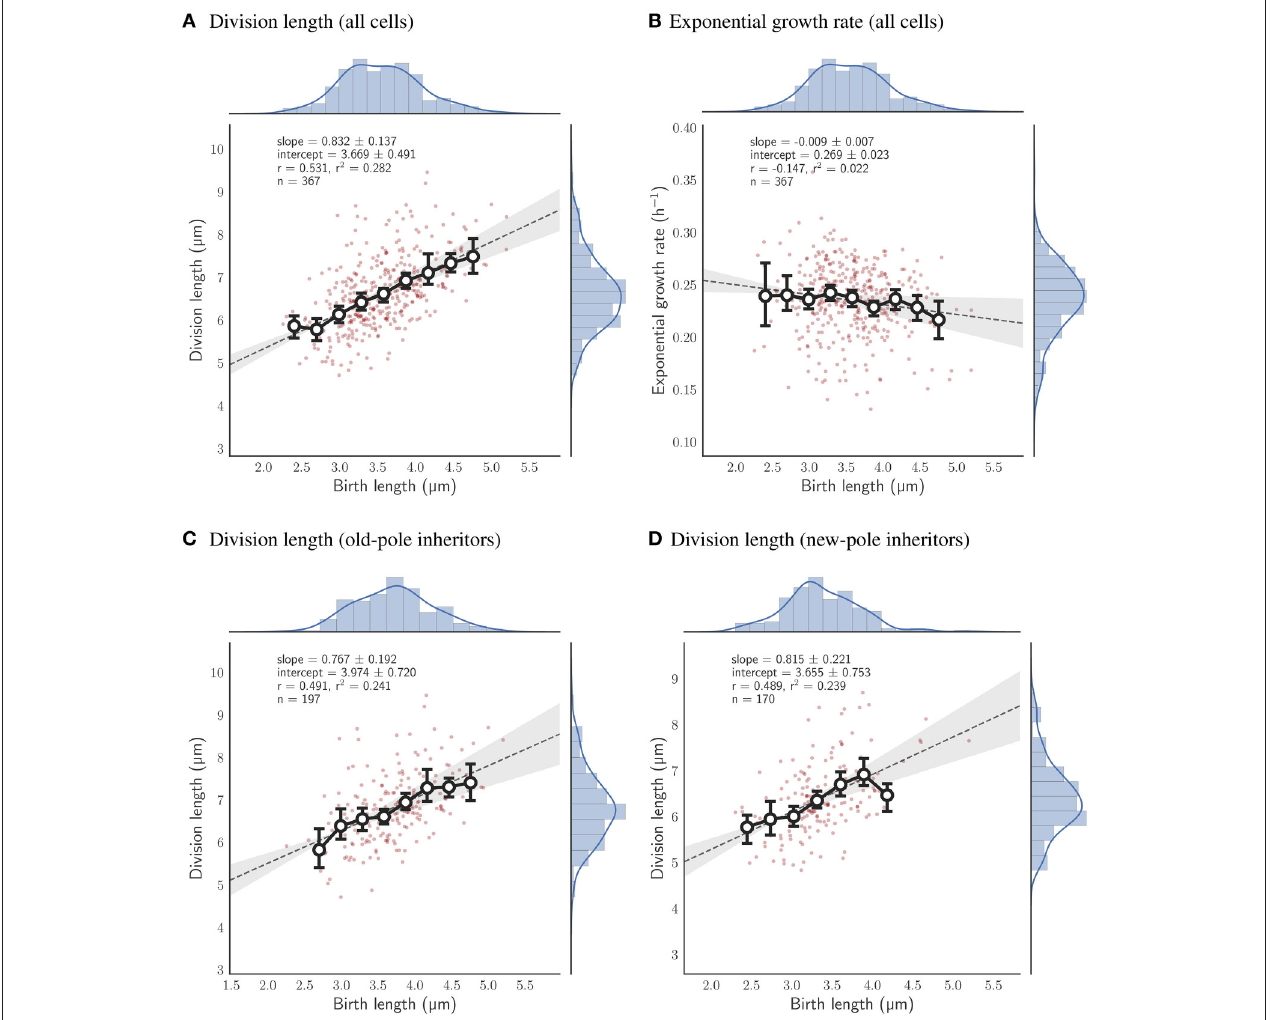
FIGURE 6 | Relationship between birth length and division length or exponential growth rate for cells grown with pyruvate as a sole carbon source. Colors and legends as for Figure 2 . (A) Relationship between birth length and division length for all cell divisions. (B) Relationship between birth length and exponential growth rate for all cell divisions. (C) Relationship between birth length and division length for cells which inherit the old-pole from their mother cell. (D) Relationship between birth length and division length for cells which inherit the new-pole from their mother